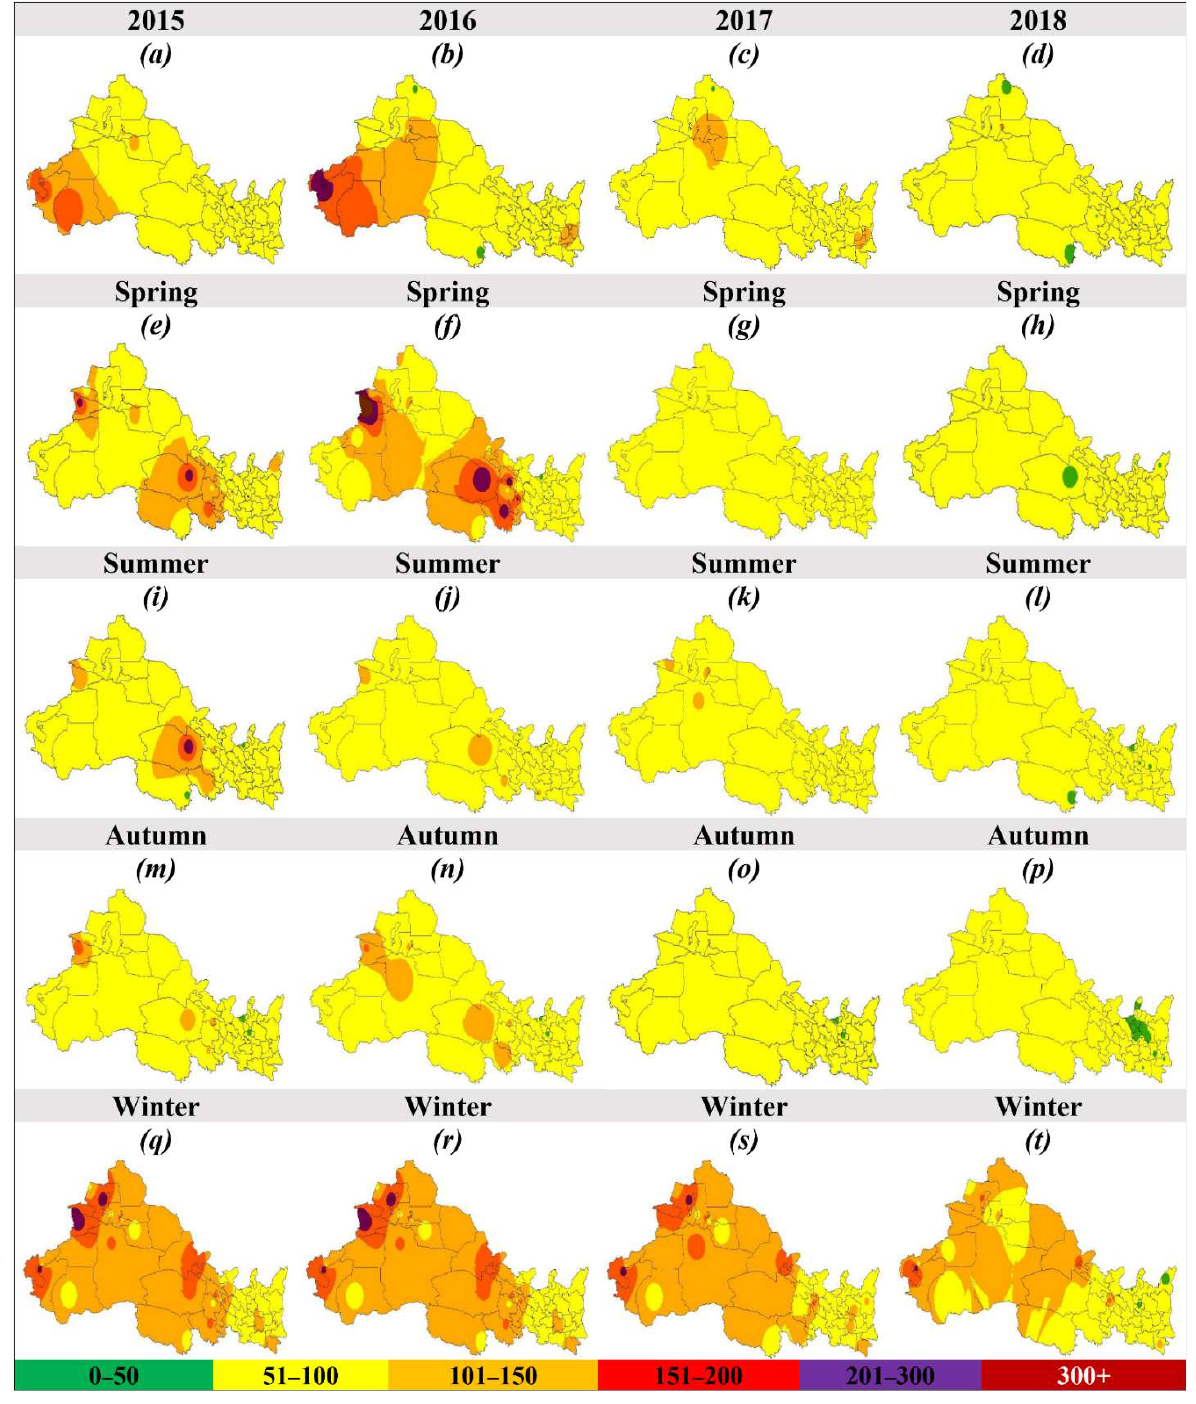
Figure 6. Annual ( a – d ) and seasonal (spring ( e – h ), summer ( i – l ), autumn ( m – p ), and winter ( q – t )) spatial distribution of AQI between 2015 and 2018 in 53 cities of northwest China (NWC). Color represents the different classes of air quality index, e.g., green (0–50, good), yellow (51–100, moderate), orange (101–150, unhealthy for the sensitive group), red (151–200, unhealthy for all), purple (201–300, very unhealthy), and maroon (300+, hazardous).